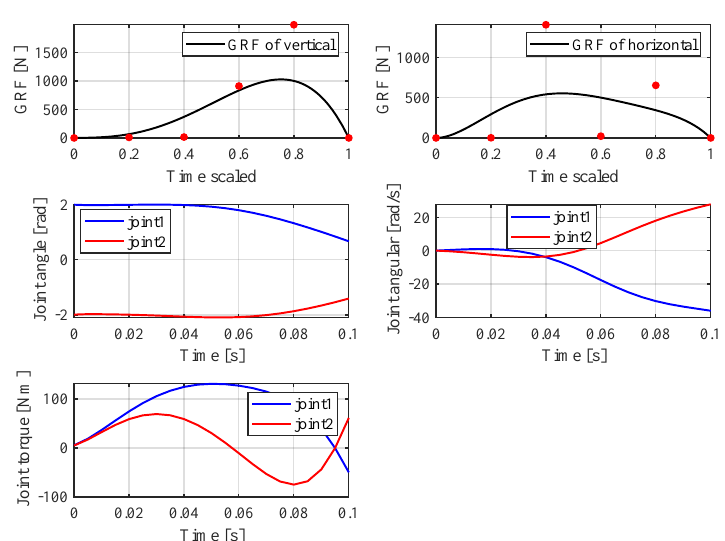
Figure 10. The simulation of horizontal jump.